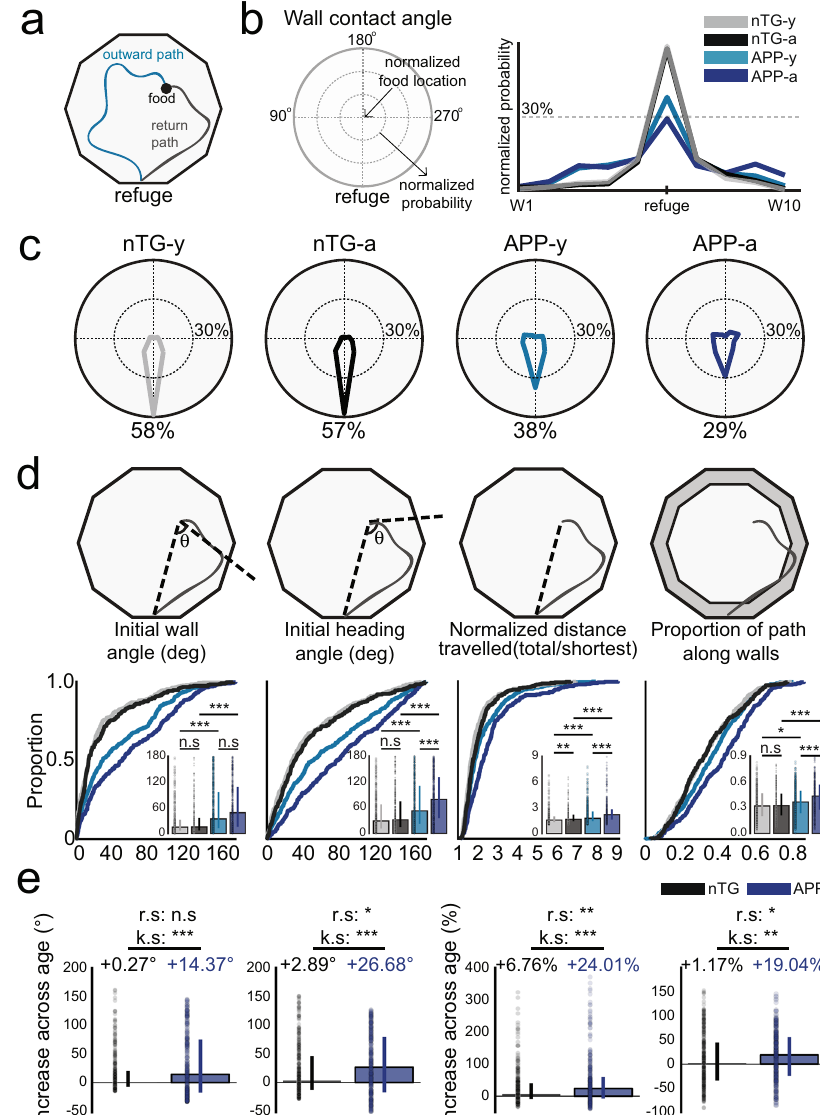
Fig. 5 Path integration is impaired in APP mice and worsens with age. a Food-foraging task in darkness where mice forage for a food pellet and navigate back to the refuge for consumption. b Likelihood of arriving at each wall (W1 – W10) during the initial wall encounter of the return path between groups. c Probability of reaching the refuge during the initial wall encounter of the return path between groups. d Initial wall angle (nTG-y-nTG-a: P = 0.50;